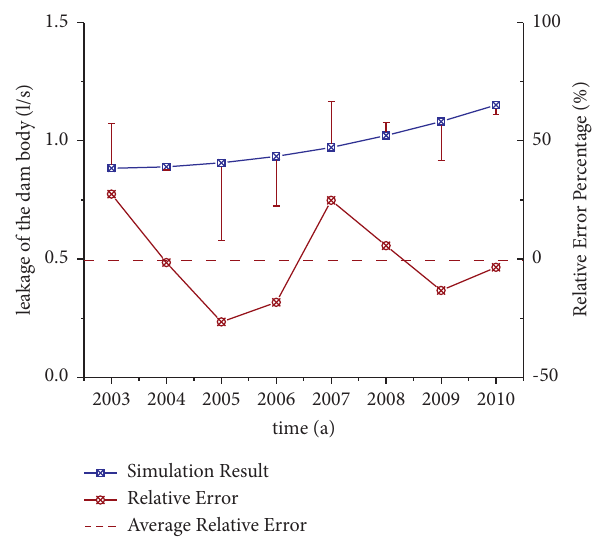
Figure 15: Comparison of the simulated dam body leakage quantity and monitored data.